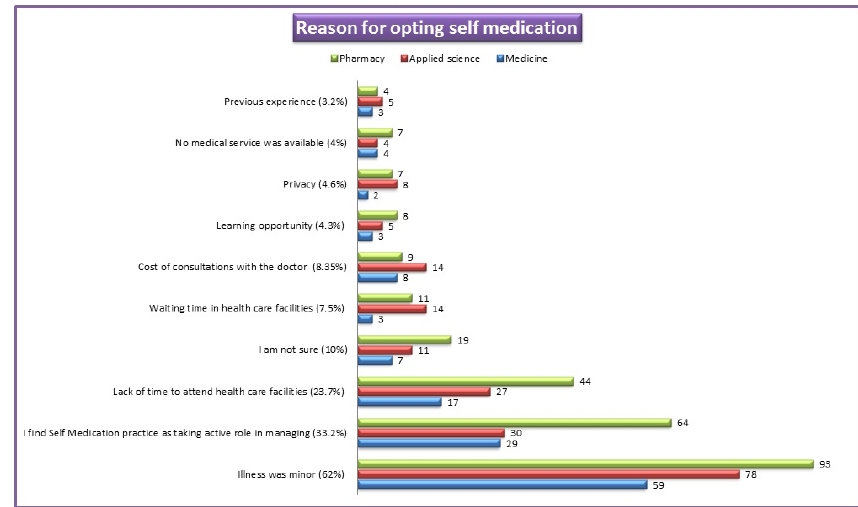
Figure 3. Reasons for opting self-medication practice.